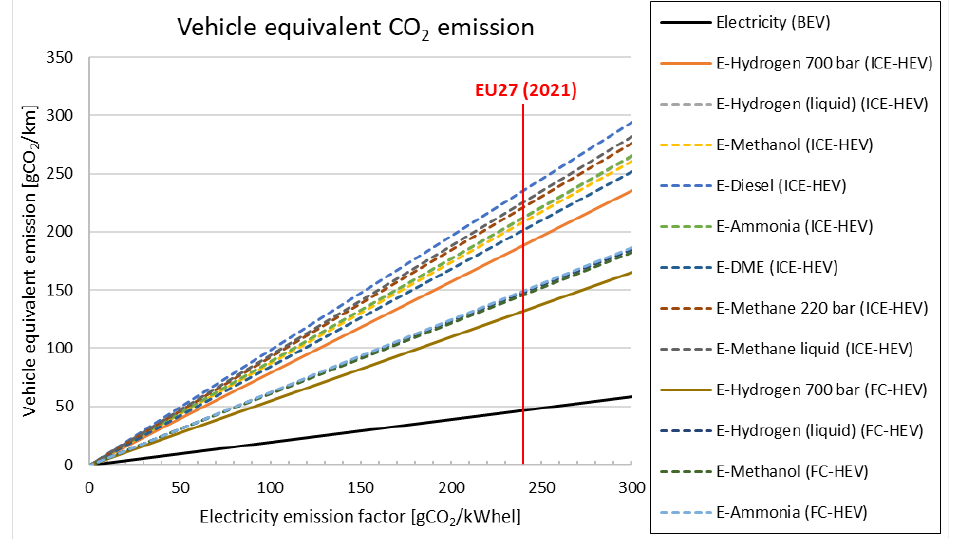
Figure 8. Equivalent CO 2 vehicle emission vs . electricity emission factor. The emissions intensity of EU27 electricity generation (the amount of GHG emitted per unit of electricity) in the last decades declined to 241 gCO 2 /kWhel (the year 2021), even if there are still huge differences among countries (maximum 736 g in Poland and minimum 58 g in France) [104]. With the current EU27 emission factor, PC-BEVs emit less than 50 gCO 2 /km, while e-fuels options would range from 140–240 gCO 2 /km (higher than current fossil fuel